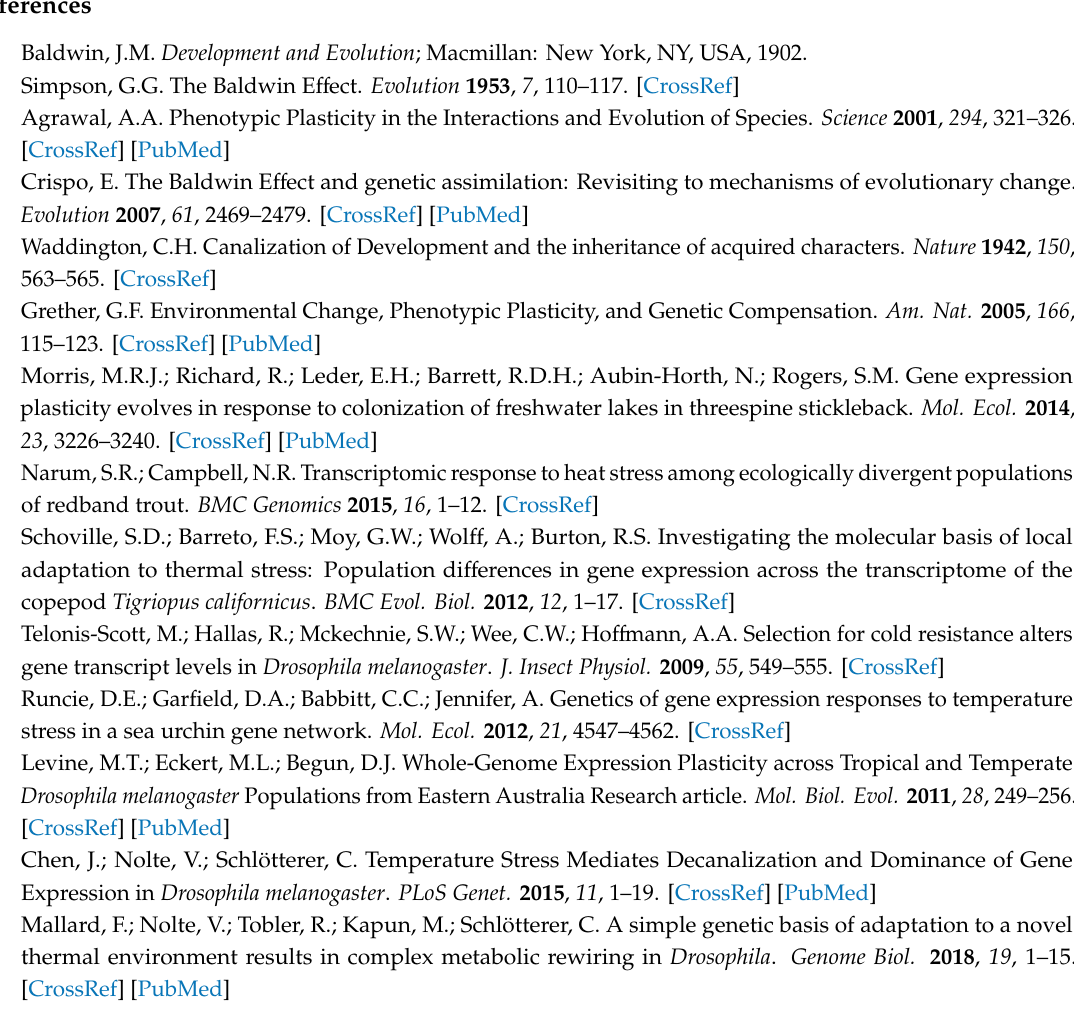
Table S1: Additional loci with high between-species variance in plasticity in males, Table S2: Additional loci with high between-species variance in plasticity in